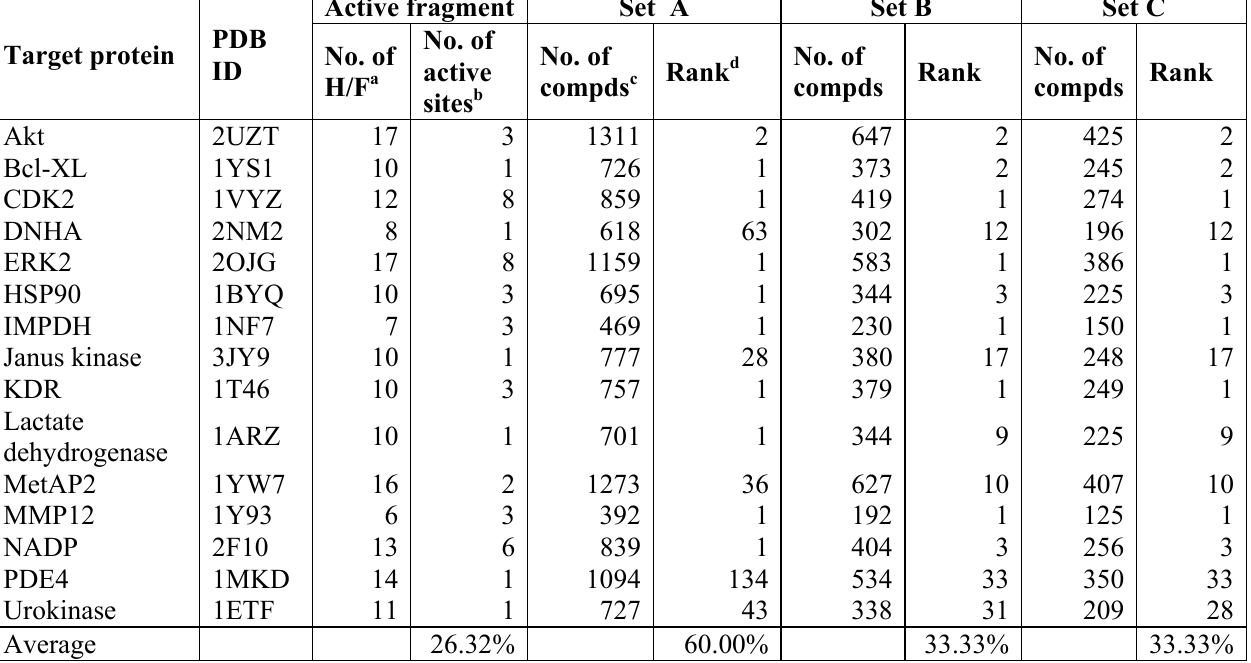
Table 1. Active position prediction accuracy by the current method.